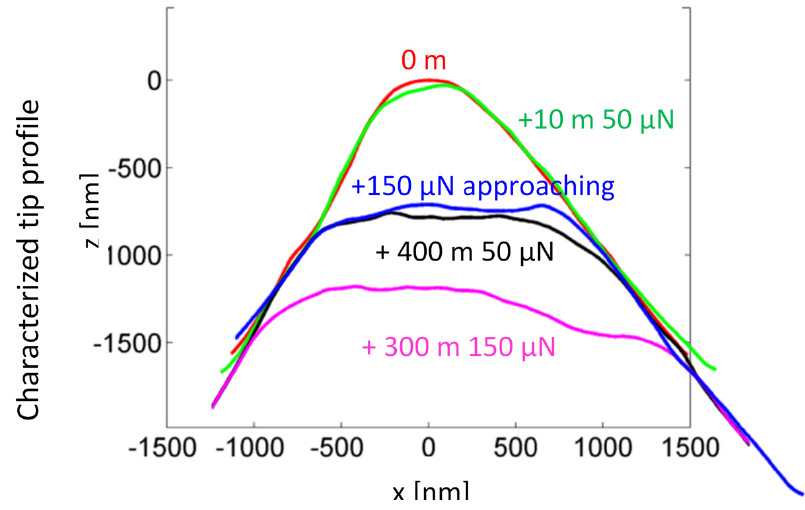
Figure 10. The tip profile changes with the probing force and the sliding distance.